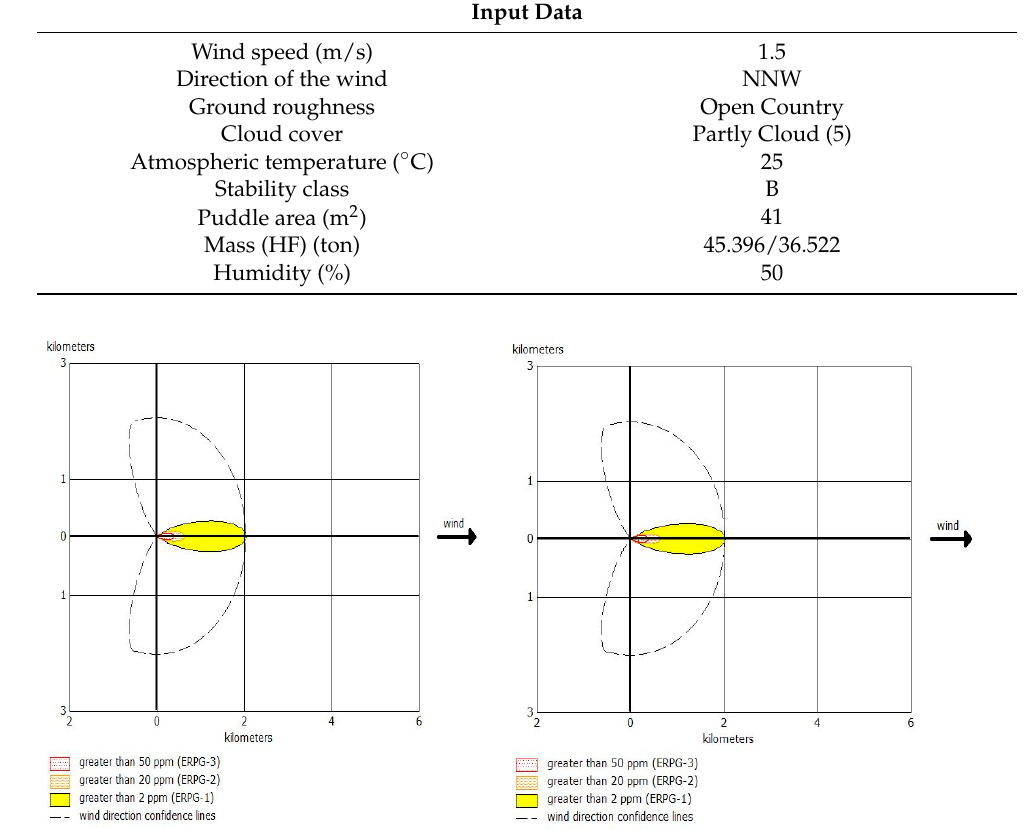
Table 2. Input data for the simulation of ALOHA.